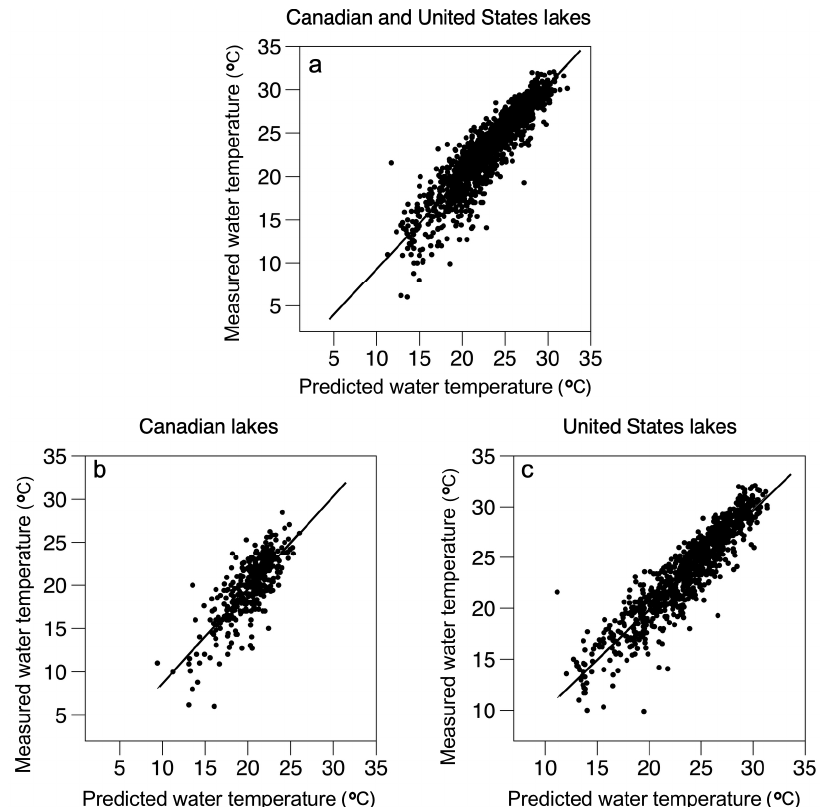
Figure 3. ( a ) Plots of measured water temperatures at 1 m in Canadian and United States lakes versus predicted water temperatures based on a common equation for lakes in both countries using information on latitude, longitude, elevation, 8-day average air temperatures and month. ( b ) Same plot for Canadian lakes alone using the same common equation. ( c ) Same plot for United States lakes alone using the same common equation. Lines represent fitted regression lines.